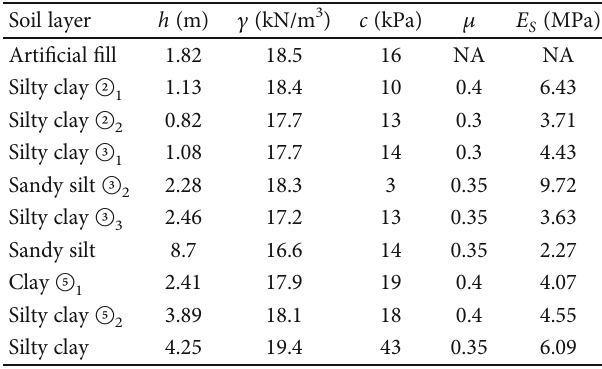
Figure 4: Site plan view for the SDRI Project. Table 2: Soil parameters for the SDRI Project [52].